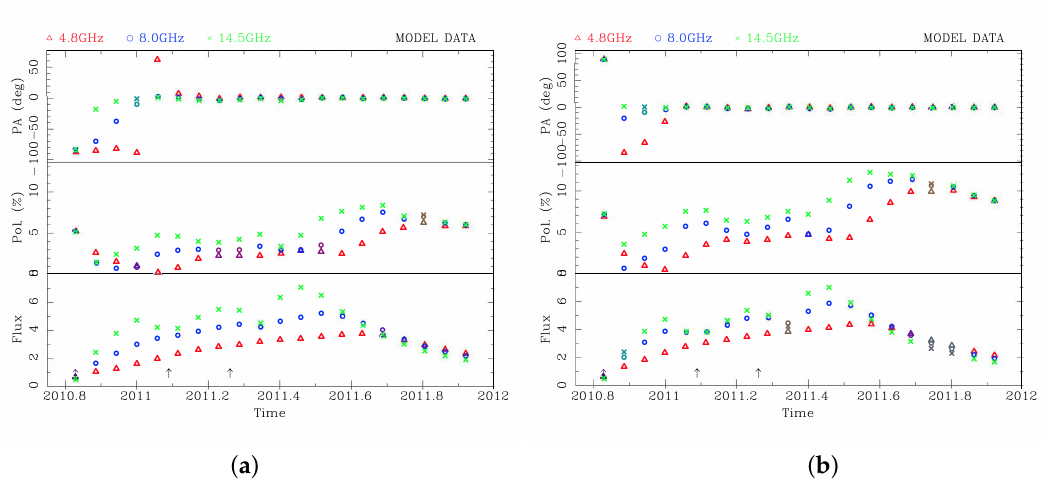
Figure 4. ( a ) The simulation for the model for T2010 with θ = 1.1 ◦ . ( b ) The simulation with the same parameters with the exception of the viewing angle, which has been changed to 1.4 ◦